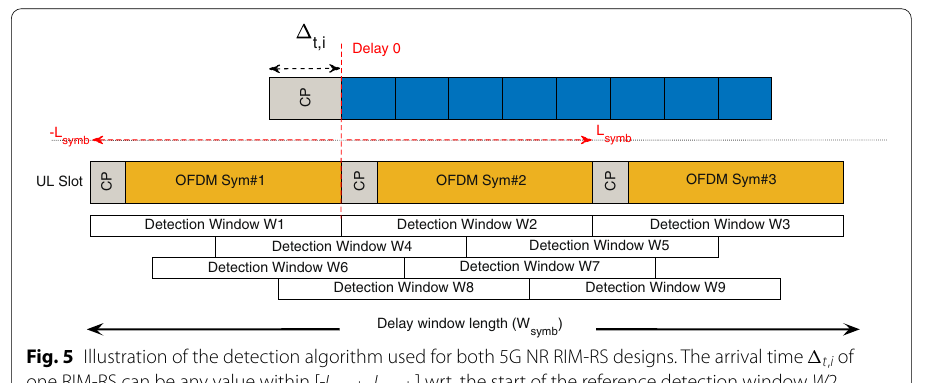
Fig. 5 Illustration of the detection algorithm used for both 5G NR RIM-RS designs. The arrival time (cid:31) t , i of one RIM-RS can be any value within [- L symb , L symb ] wrt. the start of the reference detection window W 2. Non-overlapping detection windows ( W 1, W 2, W 3) are aligned to the UL OFDM symbols and multiple overlapping windows ( W 4 to W 9) are defined to improve detection reliability